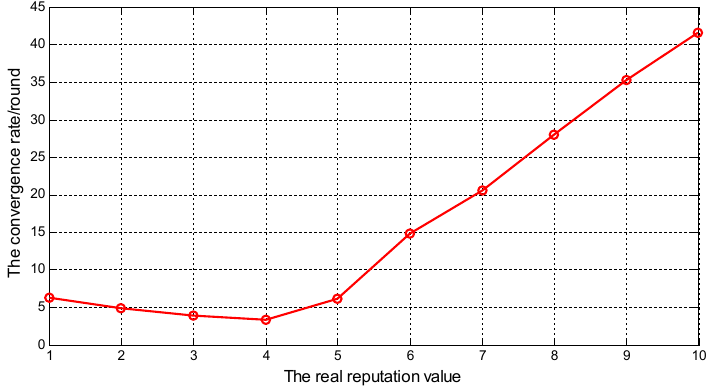
Figure 8. The comparison of the convergence time of reputation value from 1 to 10.